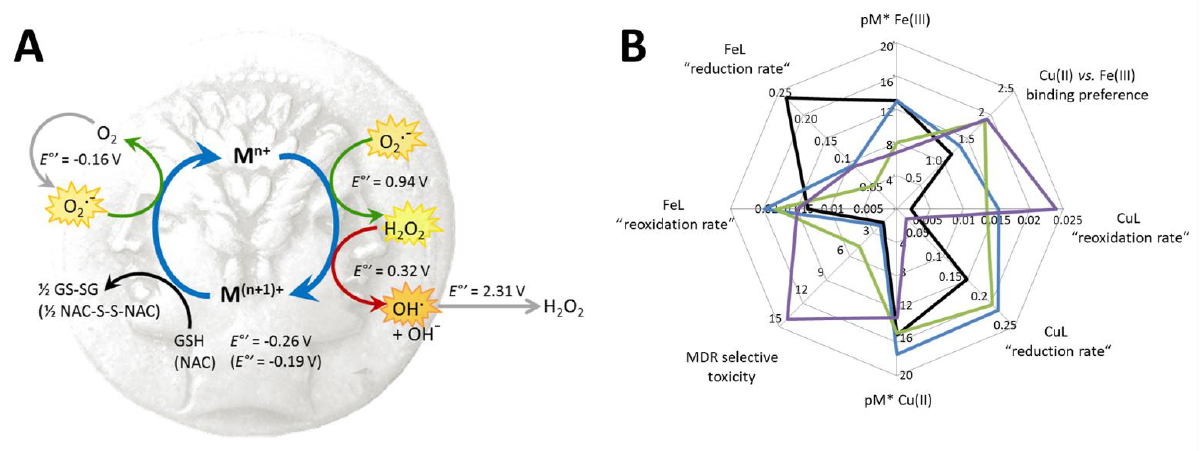
Figure 8. ( A ) Redox cycling metal ions (e.g., as part of redox active complexes, blue arrows), enable the formation of ROS (superoxide O 2− , hydrogen peroxide H 2 O 2 , hydroxyl radical OH). Formal redox potentials of respective ROS are given in 1 M solutions at physiological pH [58]. Antioxidants are Janus-faced: based on their formal redox potentials, GSH and NAC can scavenge ROS [75,76], but they can also reduce the metal ion (black arrow), thus inducing a mechanism of “activation by reduction” [37,74], giving rise to Fenton (iron)/Fenton-like (other redox active metal ions) reactions (red arrow). In the metalloenzyme superoxide dismutase (SOD), the redox active copper center catalyzes the reactions highlighted by green arrows. ( B ) Summary of metal binding preferences and redox kinetic parameters of Q-1 (black), Q-2 (blue), Q-3 (green) and Q-4 (purple). pM*: metal binding capacities of the ligands = −log(unbound metal ion).